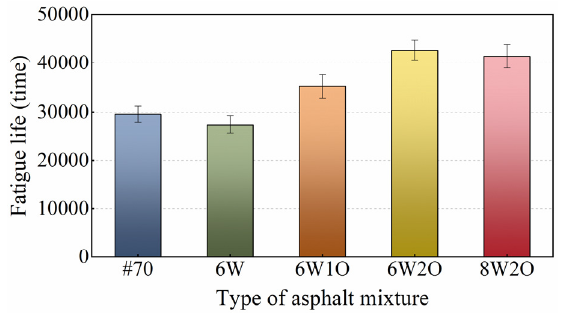
Figure 10. Test results of fatigue performance.